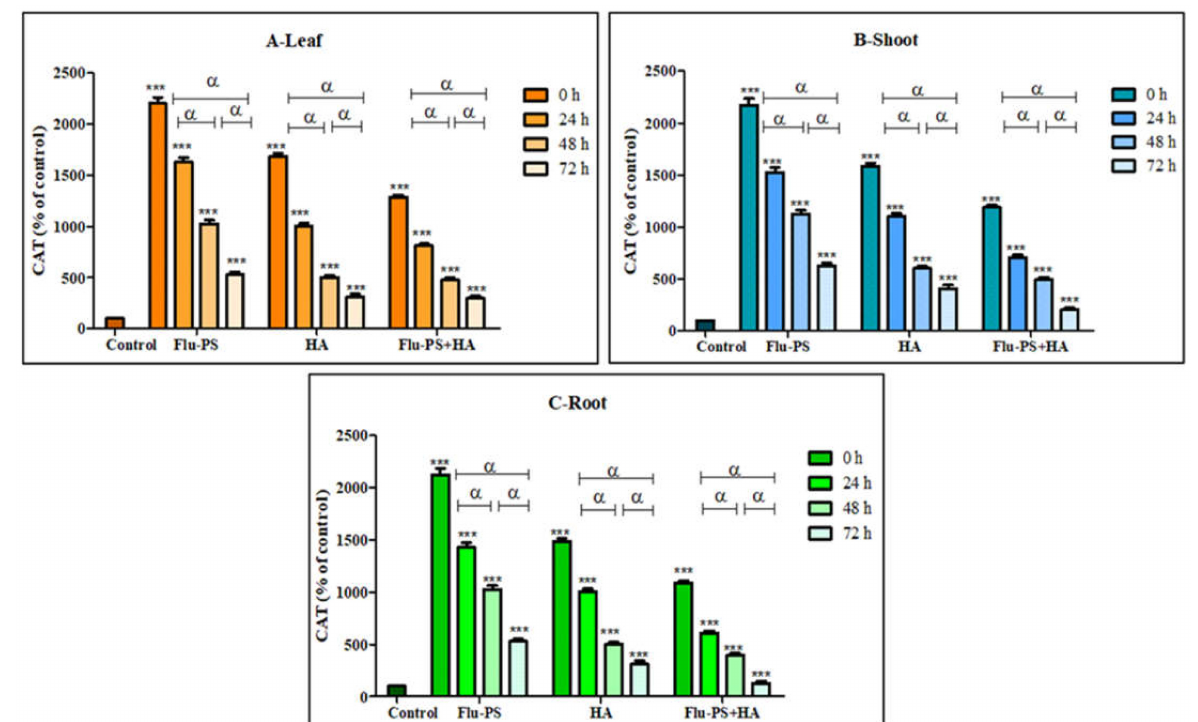
Figure 13. Percentage of Catalase values of Flu − PS, HA & Flu − PS+HA treated (( A ). Leaf, ( B ). Shoot, ( C ). Root) Solanum lycopersicum samples. Note: ‘ *** ’ indicates the percentage difference concerning the control, and ‘ α ’ indicates a significant difference ( α = p <